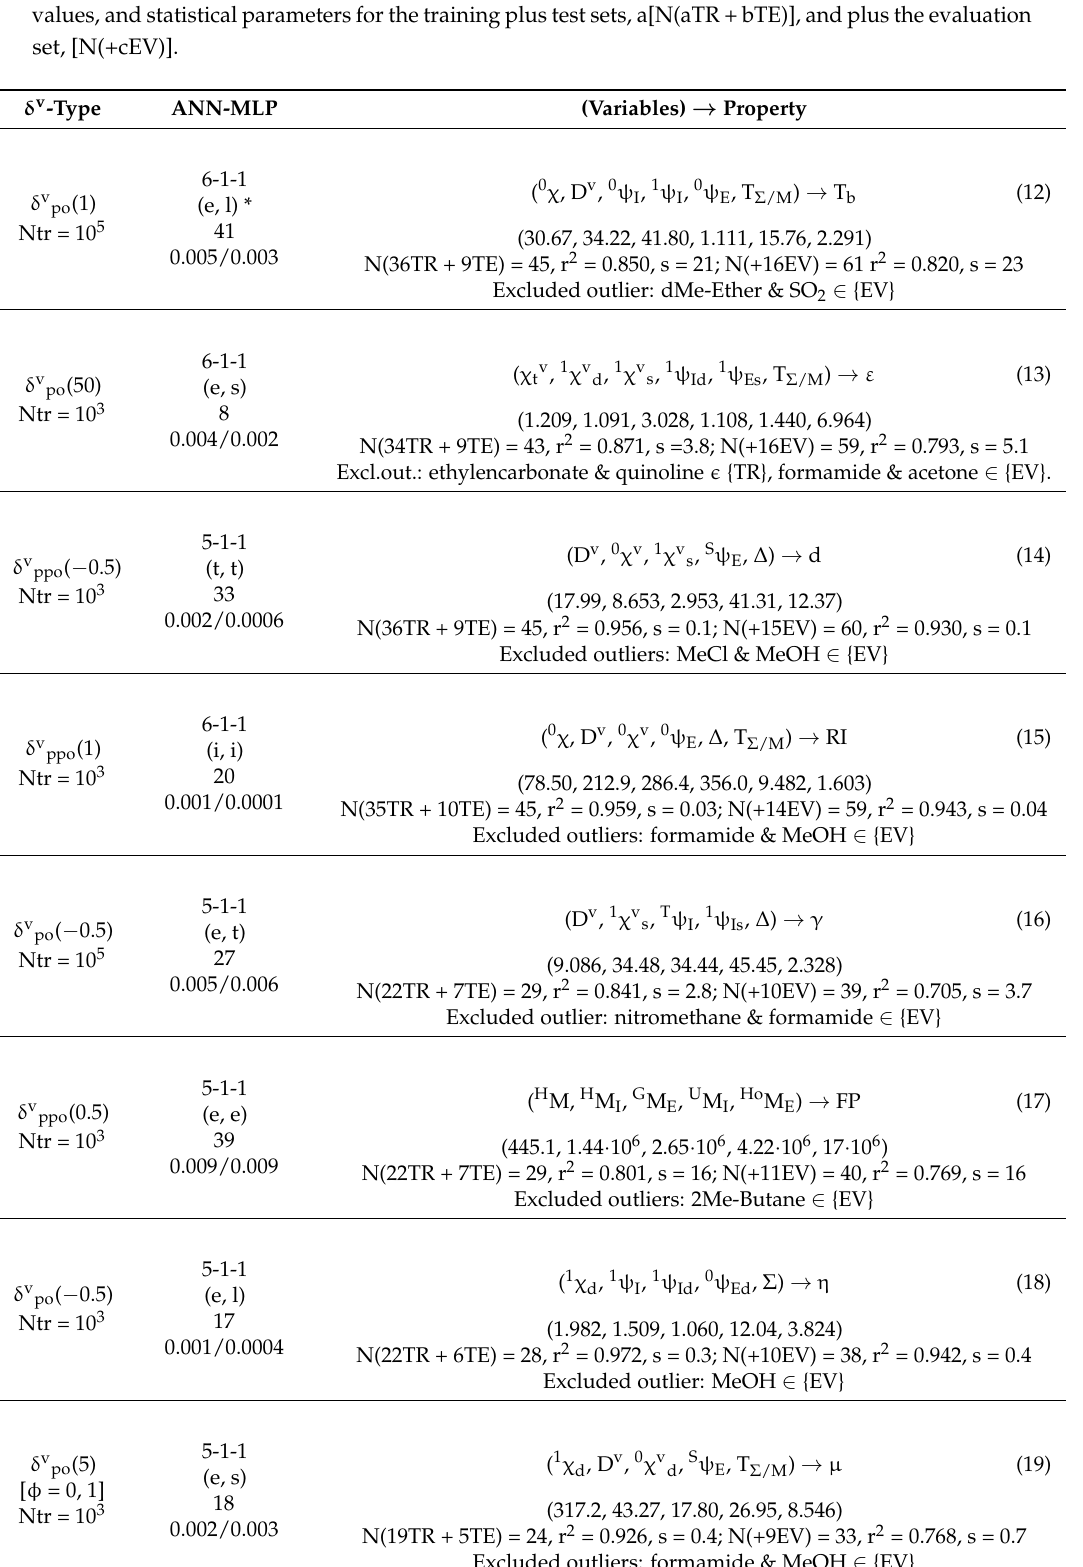
Table 5. ANN results with descriptors of Table 4 with one hidden neuron. 1st column: the δ v -type and the Ntr value; 2nd col.: ANN-MLP architecture, abbreviations for the activation functions for the internal layers, the number of epochs, and training and test errors; 3rd col.: input indices, sensitivity values, and statistical parameters for the training plus test sets, a[N(aTR + bTE)], and plus the evaluation set,